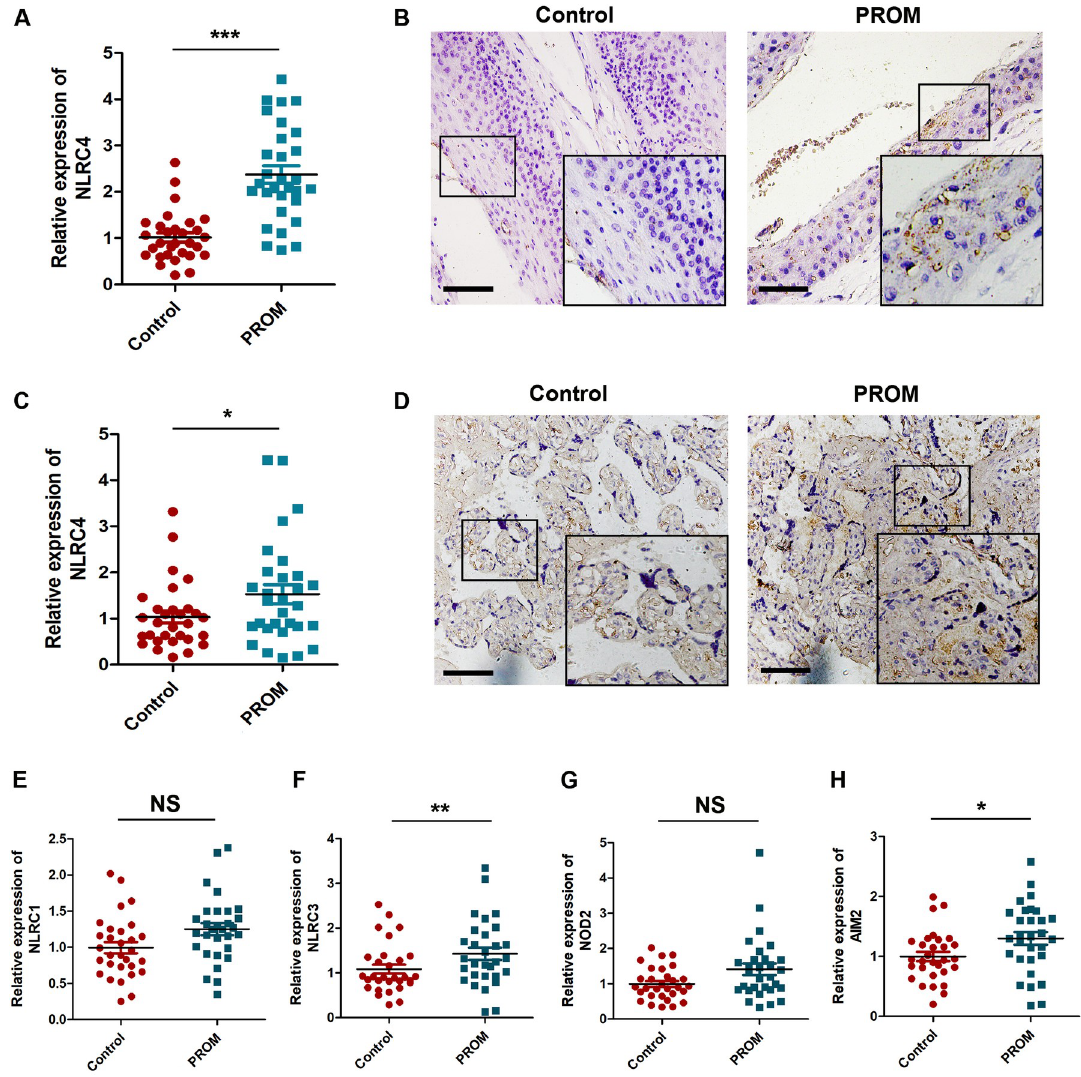
Fig 2. Increased activation of NLRC4 inflammasomes in placenta and membranes of patients with TPROM. (A) RT-PCR analysis of NLRC4 at mRNA level in fetal membrane; (B) NLRC4 immunostaining in fetal membrane was shown, bar = 100 μ m; (C) Relative mRNA level of NLRC4 in placenta; (D) Representative IHC staining images of placenta, bar = 100 μ m; (E-H) mRNA abundance of inflammasome components and NOD2 in fetal membranes, � P < 0.05, �� P < 0.01, ��� P < 0.001, NS, P > 0.05 vs the control group, n =